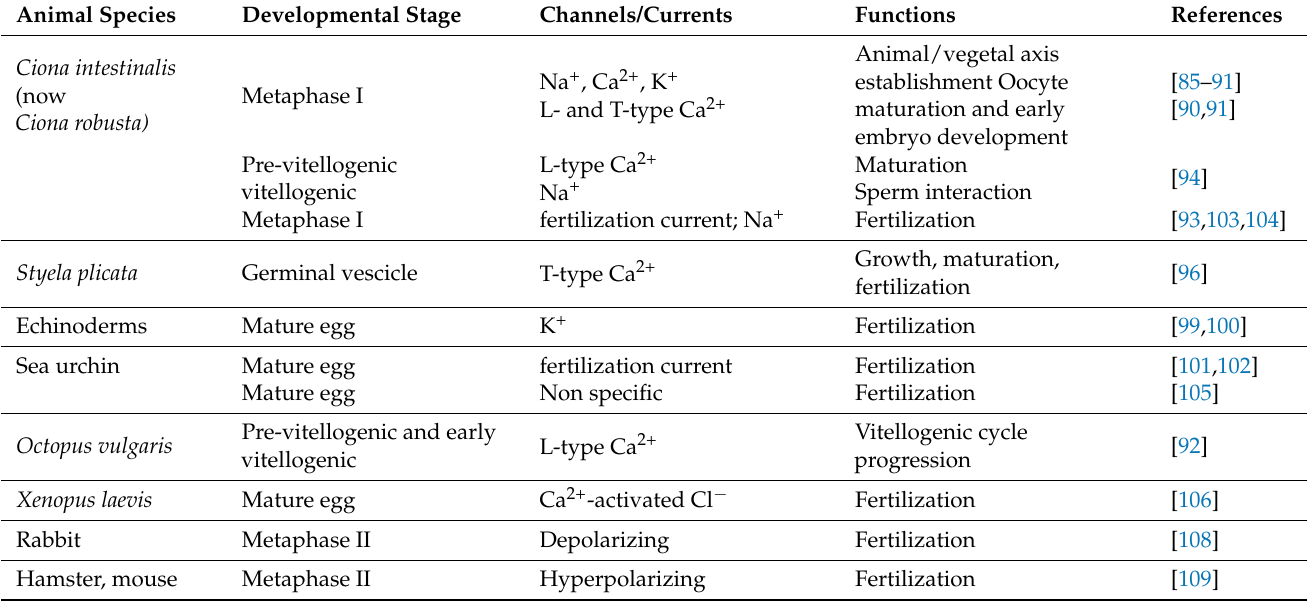
Table 3. Types and functions of ion channels/currents involved in oogenesis and oocyte maturation in animals and